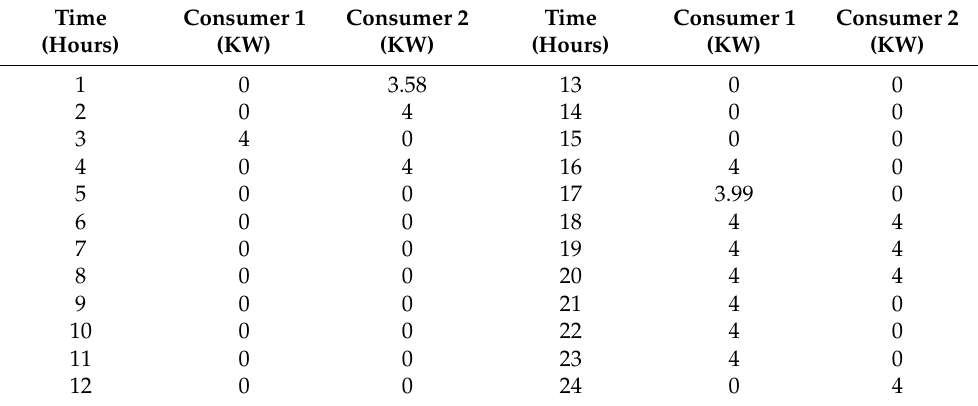
Table 9. Optimal hourly power reduction per